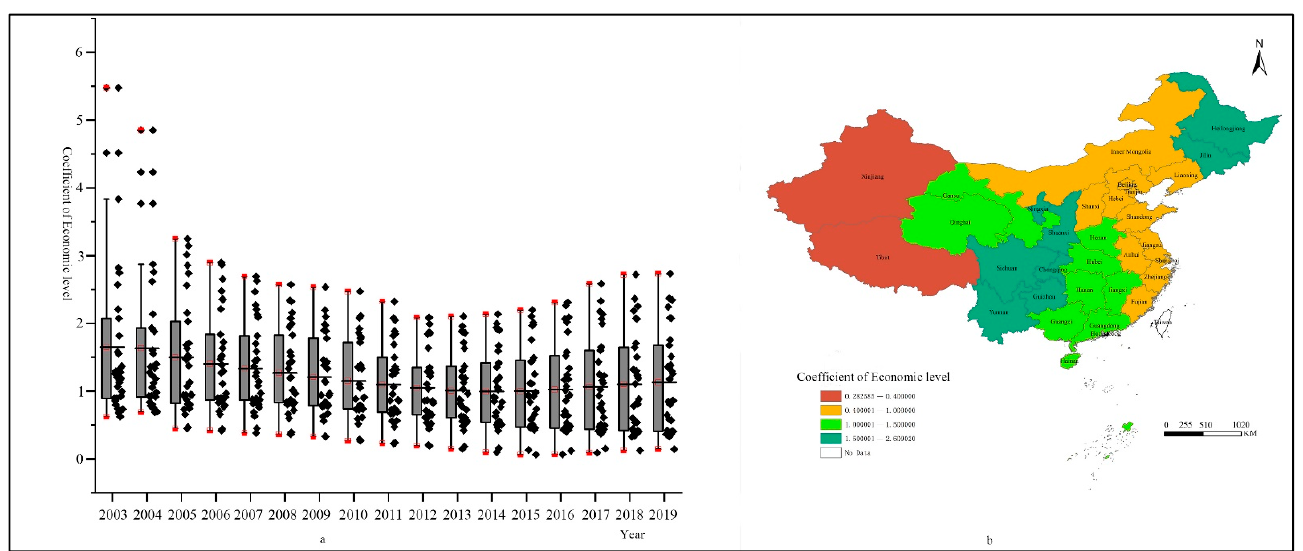
Figure 8. ( a ) Box-plot of regression coefficients of the economic level; ( b ) Distribution of mean value of regression coefficients of the economic level.